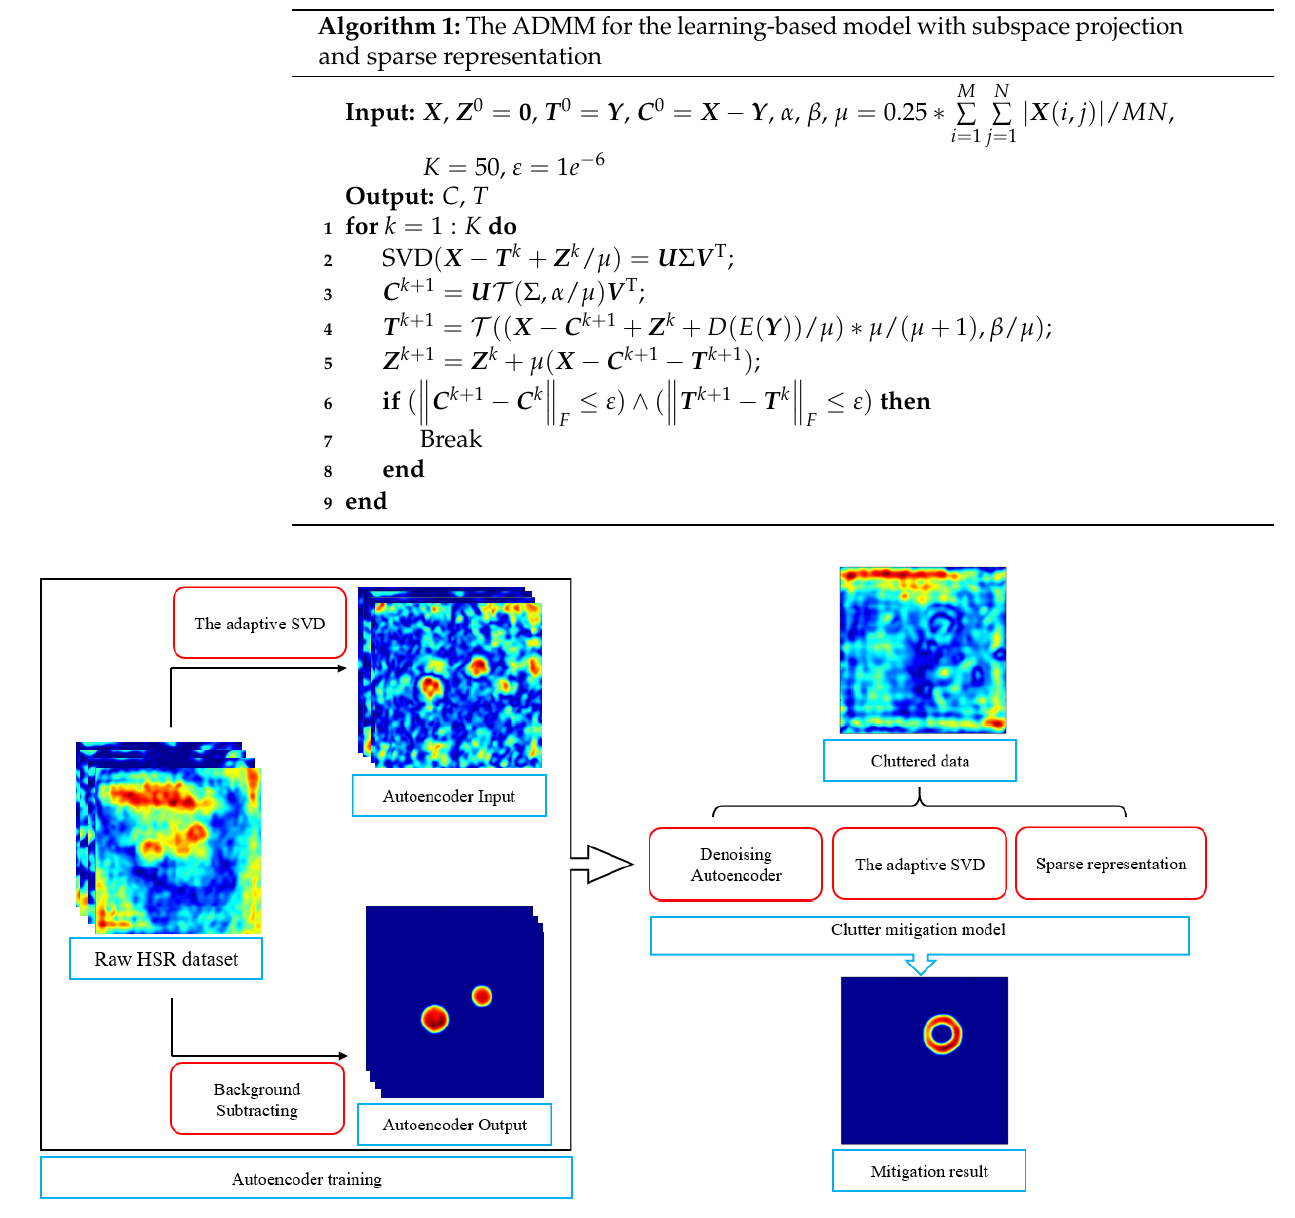
Figure 7. Structure of the proposed learning-based clutter mitigation with subspace projection and sparse representation. (Words in the blue box indicate the above datasets or models, whereas words in the red box indicate the